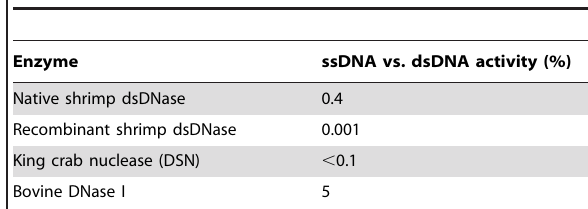
Table 1. Relative activity of various DNases on single- or double-stranded DNA oligonucleotides.